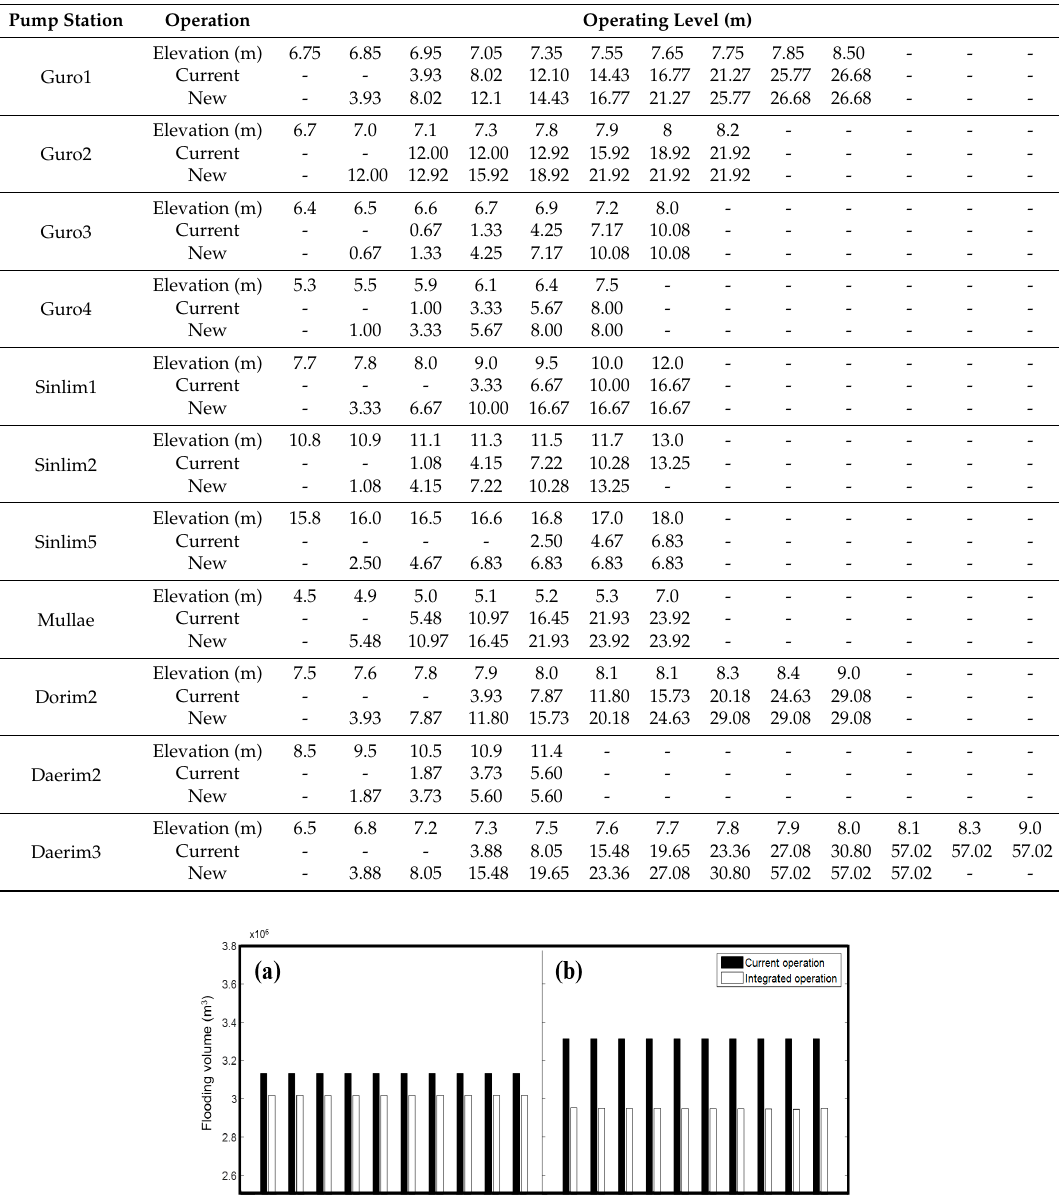
Table 9. The current and new operations of the CR for each drainage area of the Dorim stream. Pump Station